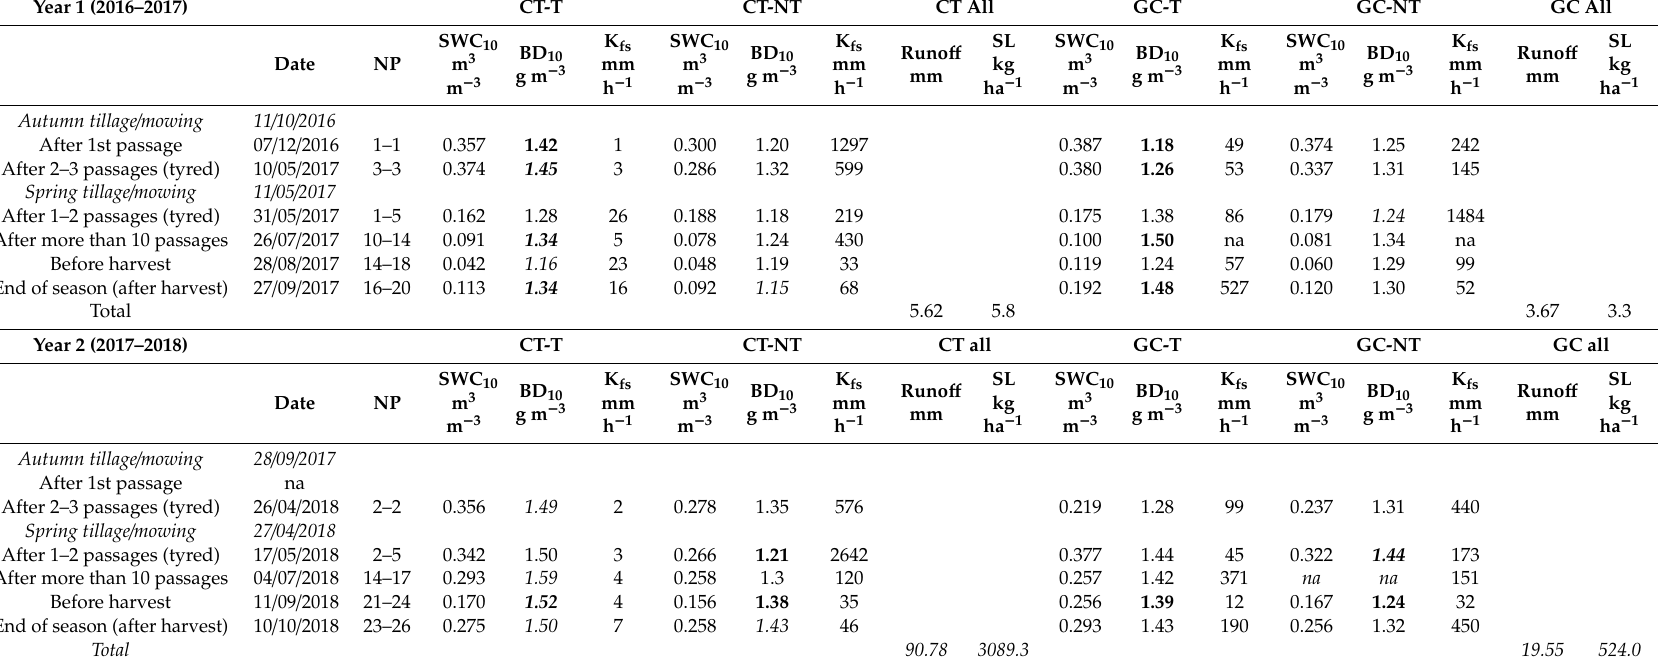
Table 4. Values of SWC, BD, and K fs measured in the topsoil in each plot and position in the two years in selected dates, which represent similar conditions with respect to the tillage operations and tra ffi c with tractors, and total values of runo ff and soil losses measured in the two vineyard plots in the two monitored years. Bold values indicate significant di ff erences (according to t -test, p = 0.05) between the values measured in the same date and same position, but di ff erent plot (i.e., CT-T vs. GC-T). Italic values indicate significant di ff erences (according to t -test, p = 0.05) observed in the same plot and position between corresponding surveys in the two observed periods (i.e., di ff erences in CT-T after 1–2 passages in Year 1 and in Year 2). Dates in italic indicates tillage and mowing